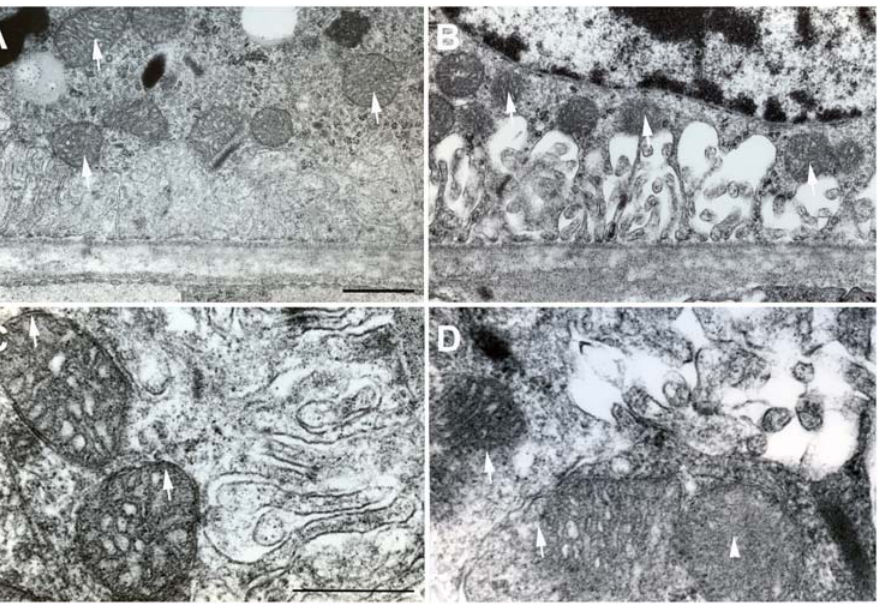
Figure 7. Transmission electron microscopy of the RPE-Bruch’s membrane. A. Control, mice exposed to air (n=5). This representative micrograph shows that mitochondrial membrane and cristae were well preserved and the matrix has homogeneous electron-dense (arrows). B. Mice exposed to cigarette smoke (n=5). This representative micrograph shows that mitochondria had lost outer membrane and there was disorganization of cristae (arrows). C. Control, mice exposed to air. This representative micrograph at high power shows intact outer membranes of mitochondria. D. Mice exposed to cigarette smoke. This representative micrograph at high power shows loss of mitochondrial outer membranes (arrows) and disorganization of the cristae (arrowhead). A, B: Scale bar=1 m m; C, D: scale bar=500 nm.